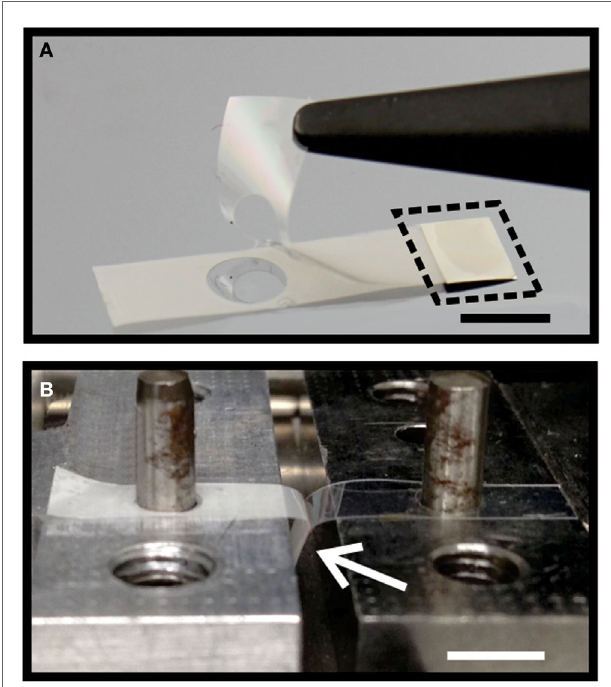
FigUre 1 | (a) Flaps of peel test sample separated with tweezers after removing sacrificial PR. Bonded metal region is circumscribed by dotted line. (B) Peel test sample placed over mounting posts on motorized stage with load cell before top clamp is secured. White arrow points to bonded region of peel test device [scale bars for (a) and (B) are 5